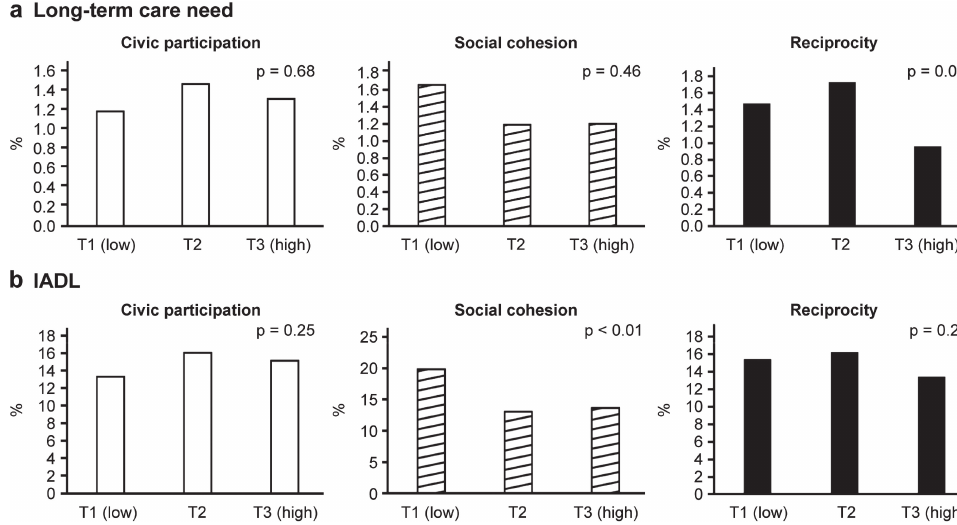
Fig. 1 Estimated prevalence of long-term care (a) and decreased IADL (b) by social capital sub-group